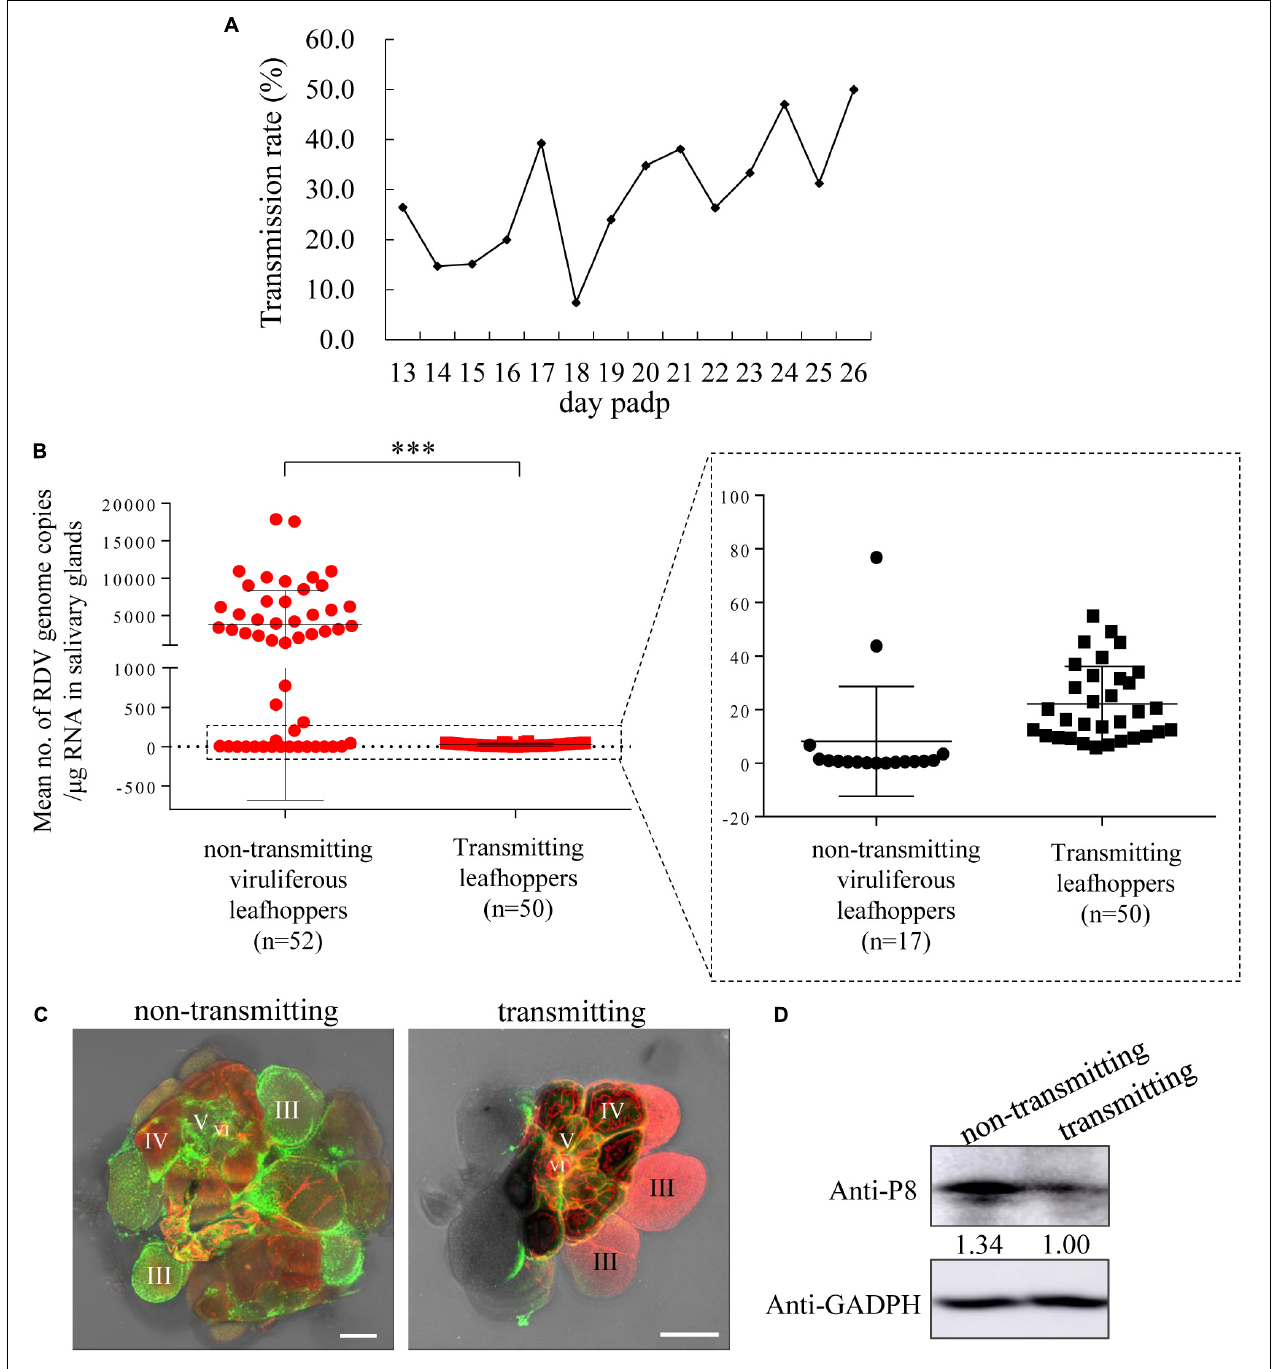
FIGURE 4 | RDV titers in the salivary glands of leafhoppers during the transmitting period were significantly lower than those in the salivary glands of viruliferous leafhoppers during the intermittent period. (A) The profile of transmission rate of RDV by a group of leafhoppers per day. The transmission rate was determined using RT-PCR to detect the presence of RDV P8 gene in plants. (B) Viral titers in the salivary glands of transmitting and viruliferous leafhoppers during the intermittent period. An RT-qPCR assay of viral titers in the salivary glands of transmitting leafhoppers was highly significantly lower than that of the non-transmitting viruliferous leafhoppers at 19 days padp. ∗ ∗ ∗ P < 0.0001. (C) Immunofluorescence microscopy exhibiting low viral infection in the salivary glands of the transmitting leafhoppers compared with viruliferous leafhoppers during the intermittent period. (D) Western blot of RDV P8 and GADPH in the salivary glands of transmitting leafhoppers and viruliferous leafhoppers during the intermittent period. The samples were separated by SDS-PAGE and the presence of P8 was examined with P8-specific antibodies. The relative intensities of bands in the analyses of P8 are shown below the bands. GADPH detected with GADPH-specific IgG is shown to demonstrate the loading of equal amounts of